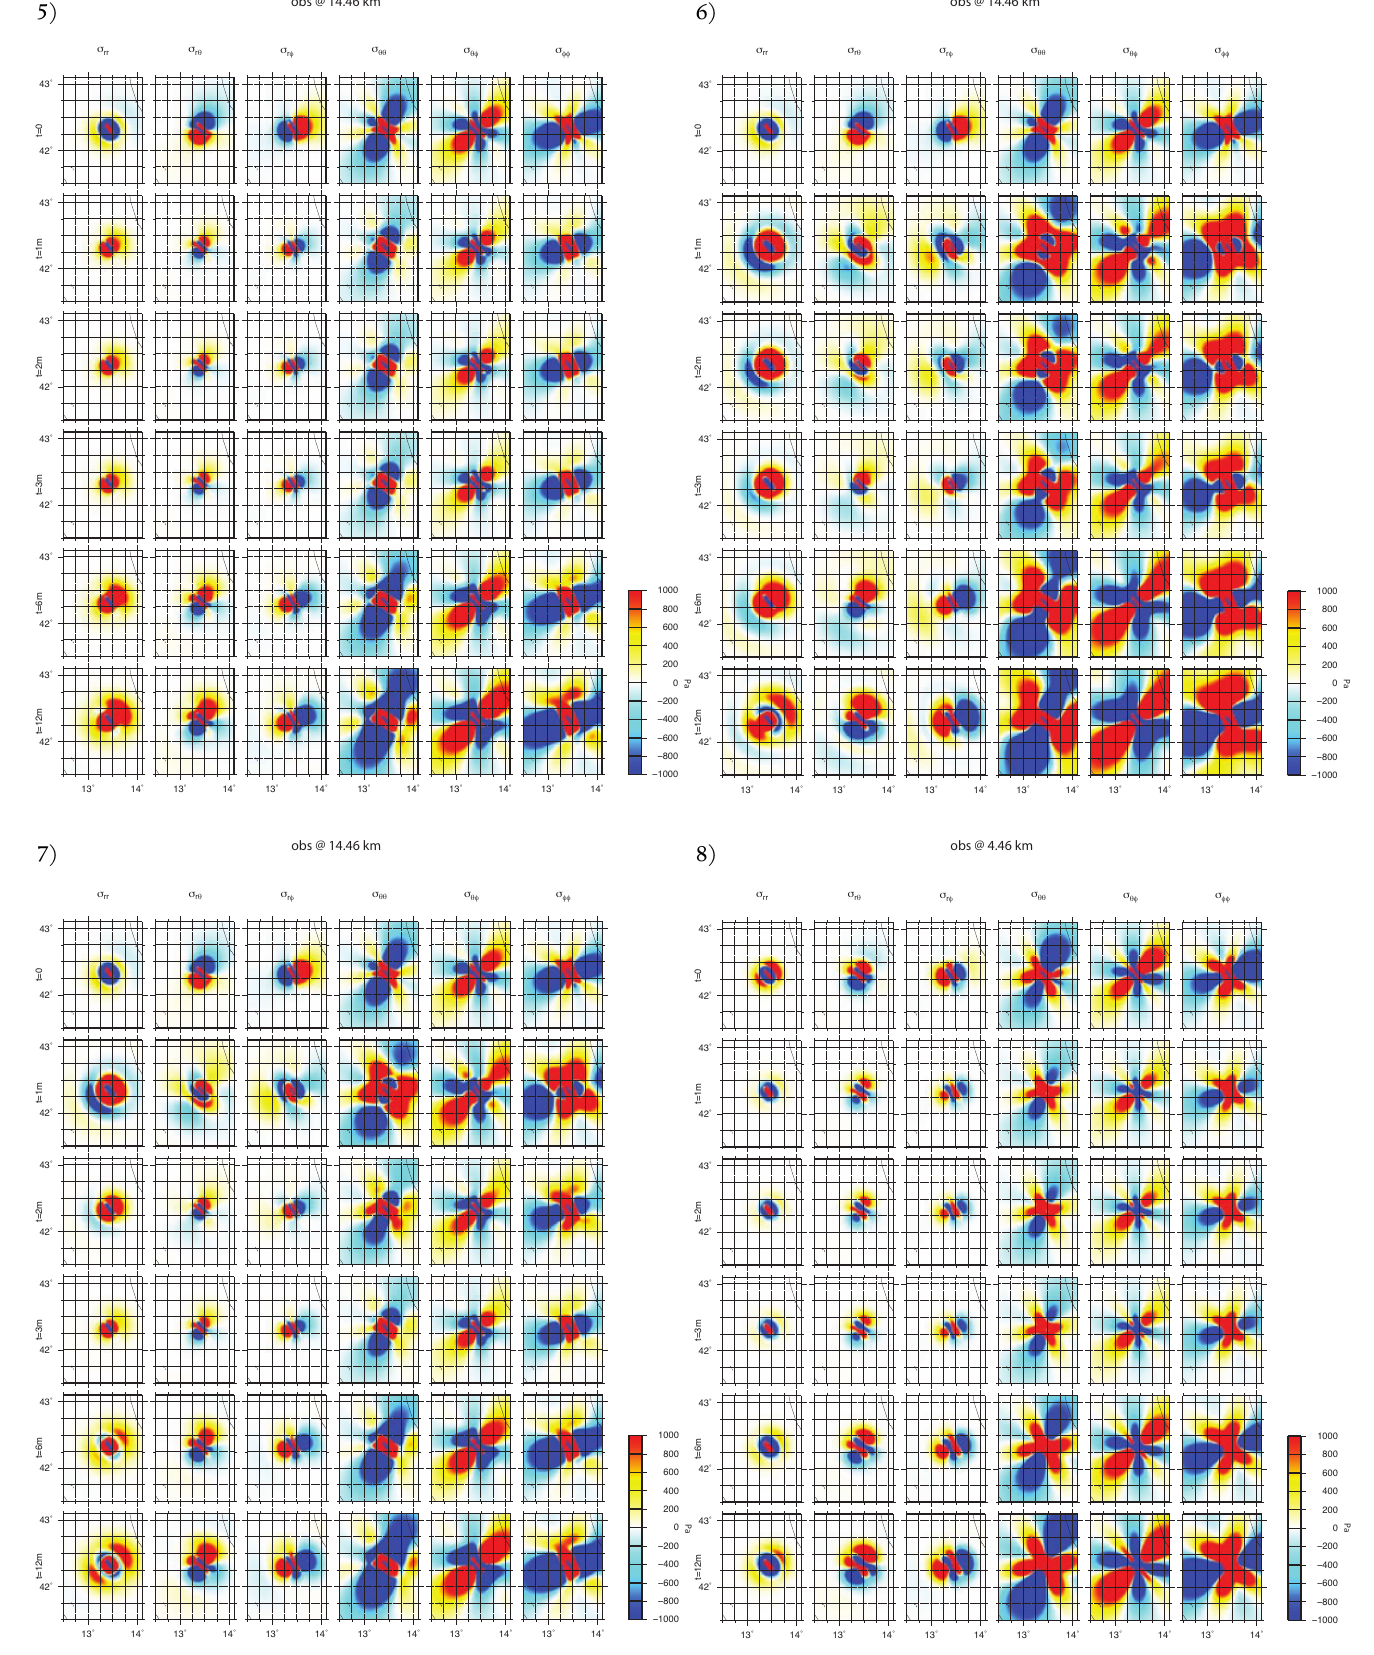
Figure 5. Temporal evolution of the stress tensor evaluated for the 2009 L'Aquila earthquake, with rheological model Mod2 (see Table 2) for the temporal steps of t = 0, 1, 2, 3, 6 and 12 months (as indicated), each with respect to the previous time step, except for t = 0, which represents the reference stress co-seismic field. The observeris located at 14.46 km in depth. The stress is expressed in Pascal (Pa). For the first step, the color scale range has to be multiplied by a factor of 10. Figure 6. As for Figure 5, with rheological model Mod3 (see Table 2), and the observer located at 14.46 km in depth. Figure 7. As for Figure 5, with rheological model ModB (see Table 2), and the observer located at 14.46 km in depth. Figure 8. As for Figure 5, with rheological model Mod2 (see Table 2), and the observer located at 4.46 km in